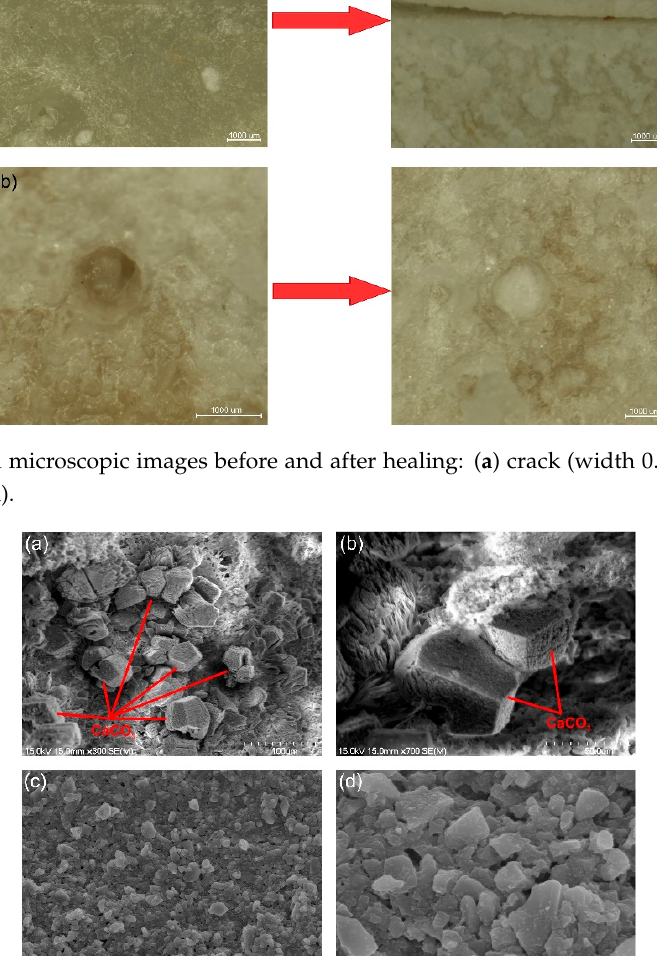
Figure 4. Optical microscopic images before and after healing: ( a ) crack (width 0.7–1 mm) and ( b ) cavity ( Φ = 1 mm).